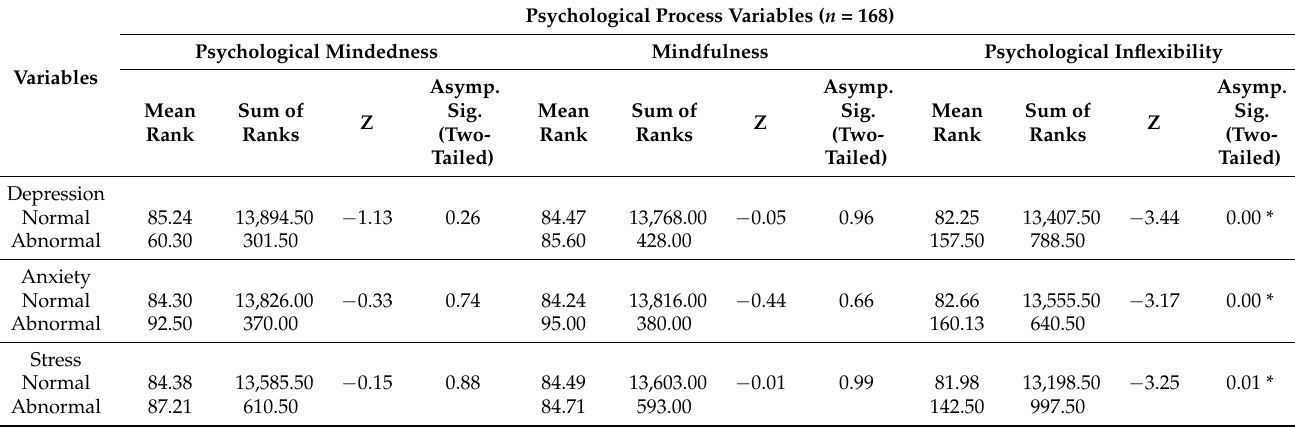
Table 10. Association between psychological distress and psychological process